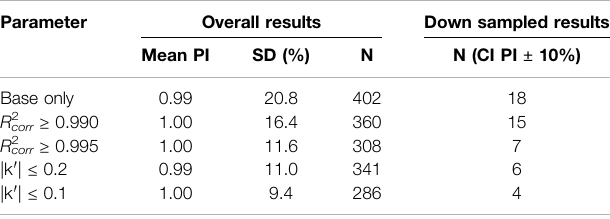
TABLE 3| Simulatedpalaeointensity resultsandstandarddeviationsaccordingto the selection criteria used. The base selection criteria ( Table 2 ) are applied in all scenarios. Overall results: Mean PI, mean palaeointensity; SD (%), standard deviation; N, number of results to pass the selection criteria. Down sampled results: N (CI PI ± 10%), number of randomly sampled results required for the 95%con fi denceintervaltobewithin10%ofthecorrectmeanresult(thelower the